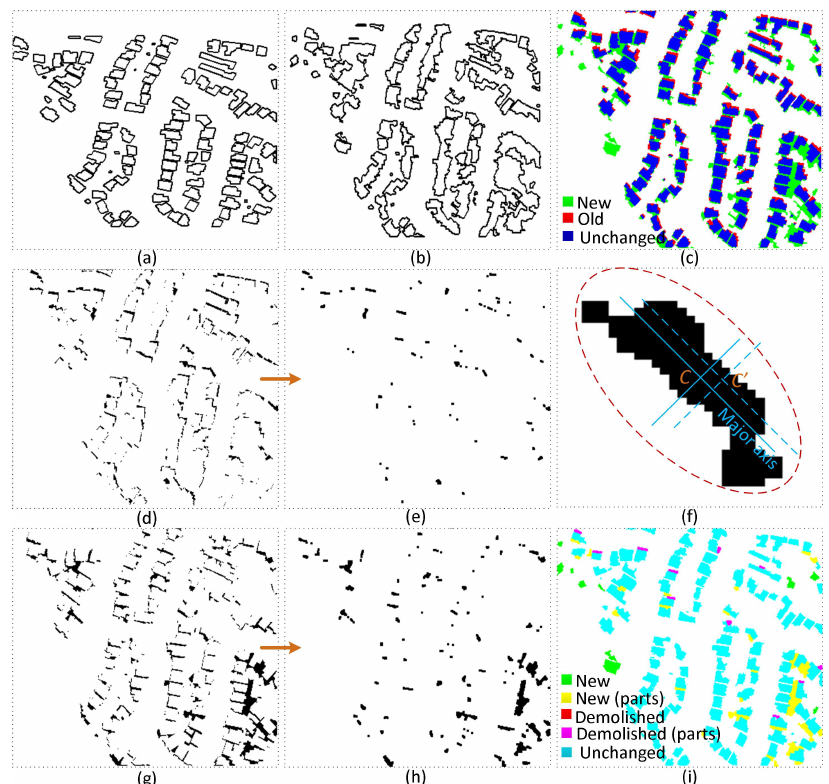
Figure 3: Change detection: (a) existing building map, (b) extracted buildings from new data, (c) mask from (a) & (b) showing old, new and existing building/parts, (d) mask for old building parts only, (e) morphological opening of (d), (f) estimation of length and width of a component in (e) or (h), (g) mask for new building parts only, (h) morphological opening of (g), (i) final change detection results.